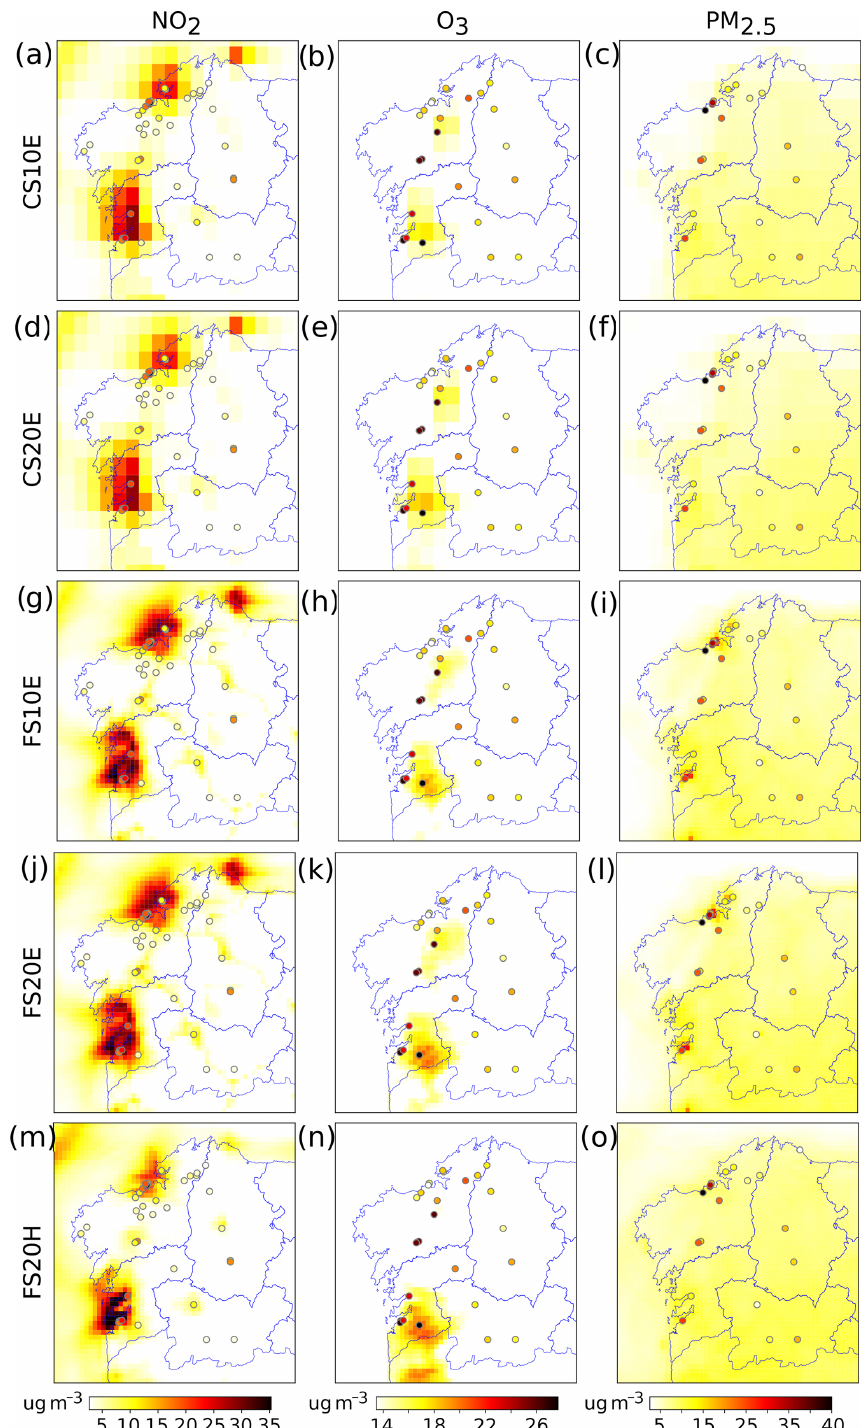
Figure 3. Observed (dots) vs. modeled (underlying pattern) temporal standard deviation values for the daily maximum concentrations of NO 2 , O 3 and PM 2 . 5 , as well as the five experiments marked with an asterisk in Table 3), all run with the SAPRC mechanism. The spatial verification results for each panel are provided in Table